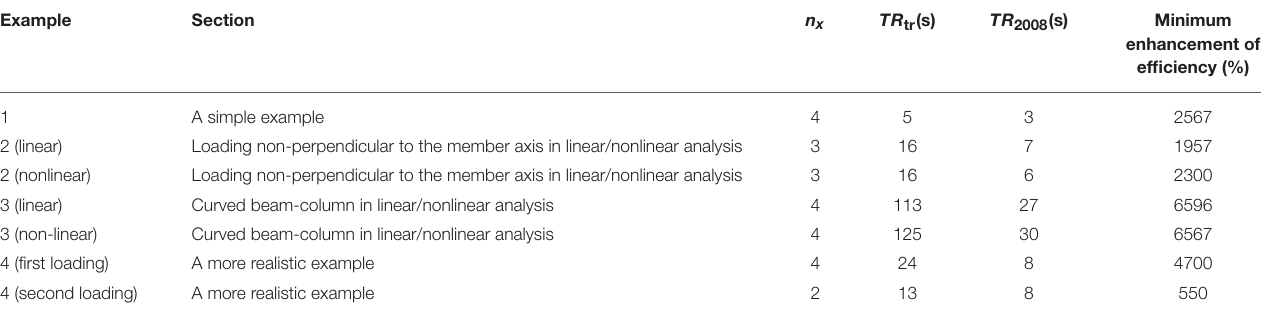
TABLE 5 | Values of n x , TR tr , and TR 2008 in the four examples studied in Sections A Simple Example, Complicated Examples, and A More Realistic Example*.